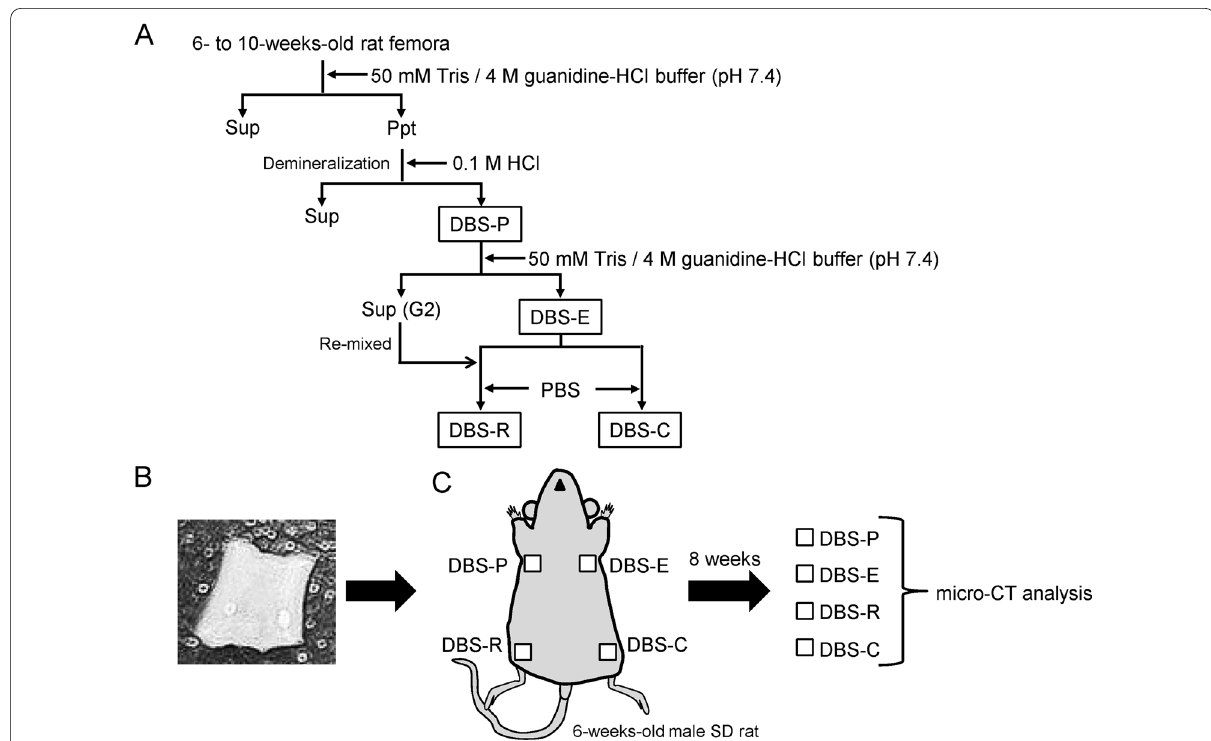
Fig. 1 Preparation of demineralized bone sheets and animal transplantation experiments. A Flow chart showing the procedures used to generate four types of demineralized bone sheets. Sup: supernatant, Ppt: precipitate. B Photograph of a representative demineralized bone sheet. Each demineralized bone sheet was trimmed to approximately 3.0 mm (width) 3.0 mm (depth) 0.3 mm (height). C Schematic diagram showing × × the procedures for the animal transplantation experiment. The demineralized bone sheets, DBS‑P, DBS‑E, DBS‑R and DBS‑C, were transplanted subcutaneously under the axilla of 6‑week‑old male SD rats. The rats were sacrificed 8 weeks later, and the demineralized bone sheets were recovered. Each demineralized bone sheet was analysed with a micro‑CT system